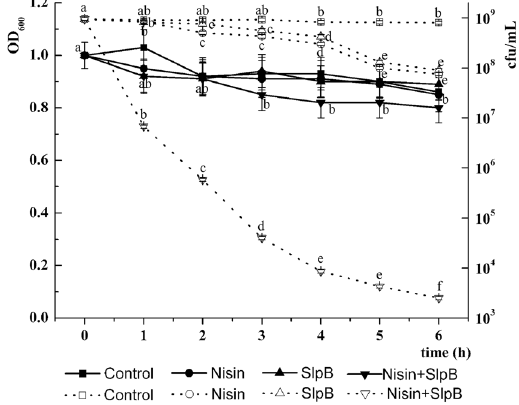
Figure 1. Lytic curves of SlpB, nisin, or nisin + SlpB. Exponentially growing bacteria were incubated in the presence of nisin, SlpB or nisin + SlpB. Nisin concentration, 100 μ g/mL; SlpB, 40 μ g/mL. Three or more independent experiments were performed. Dotted line, cfu/mL; unbroken line, OD 600 . Different letters in the curve indicate significant difference (p <